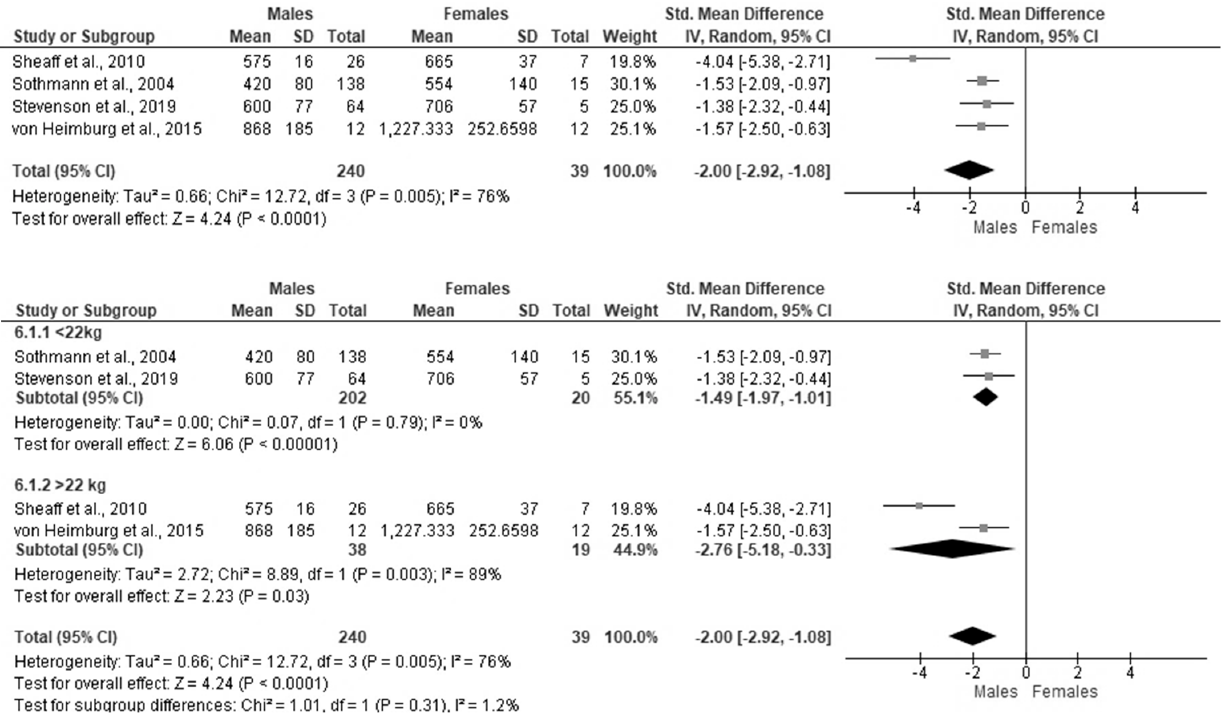
Figure 3. The effect of gender on occupational performance in firefighters. Subgroup analysis on the weight of PPE. weight of